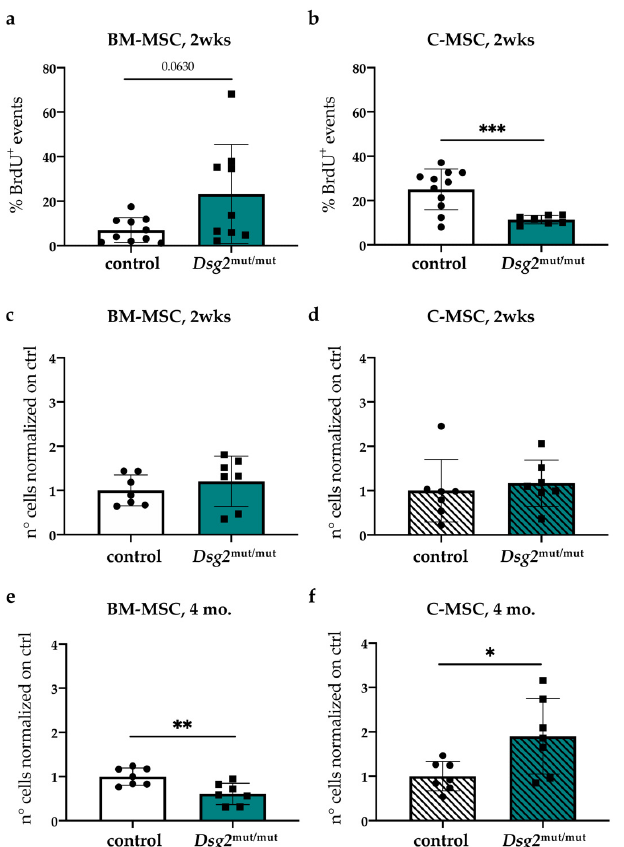
Figure 7. Cardiac and bone marrow mesenchymal stromal cell compartments are affected in Dsg2 mut/mut mice. ( a – b ) In vivo BrdU incorporation assay in young control vs. Dsg2 mut/mut mice. The fraction of BrdU incorporating BM- ( a ) and cardiac- ( b ) MSCs was quantified by flow cytometry. Bars represent mean, and error bars represent standard deviation (SD). *** p ≤ 0.001. ( c – f ) Quantification of cardiac- ( d,f ) and BM- ( c,e ) MSC content, evaluated in young (2 wks) ( c – d ) and adult (4 mo.) ( e – f ) control and AC mice. Bars in ( c,f ) represent mean, and error bars represent standard deviation (SD). n = 7 mice per condition. * p ≤ 0.05; ** p ≤ 0.01.